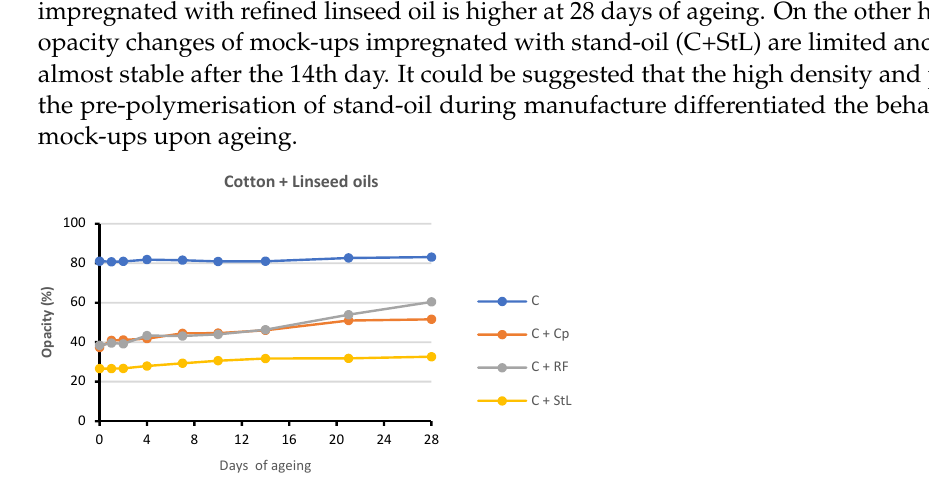
7 Figure 3. Graph representing colour changes ( ΔΕ *) of all sets of mock-ups upon ageing.